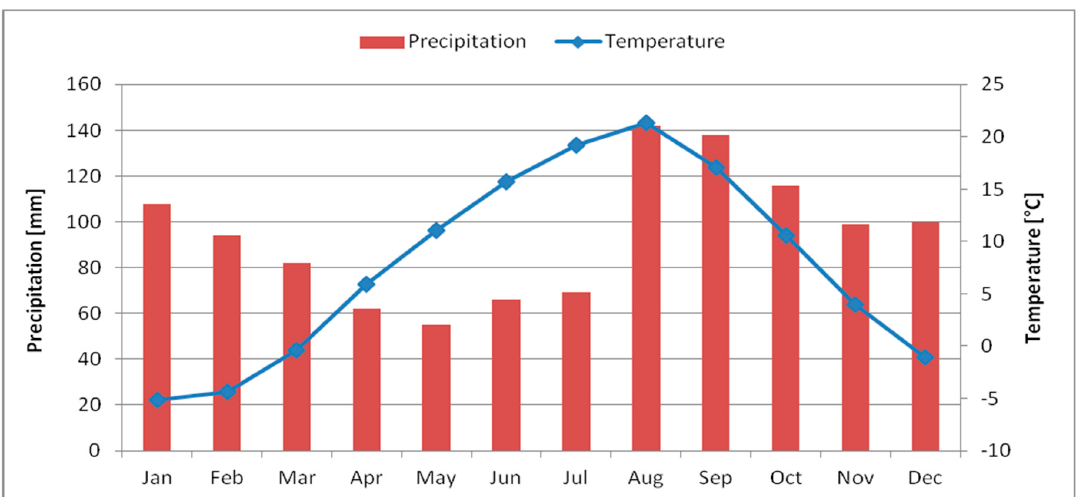
Figure 1. Average precipitation sums in mm and average annual temperature in °C from 1983 to 2012 in Sapporo, Japan provided by the Japan Meteorological Agency.